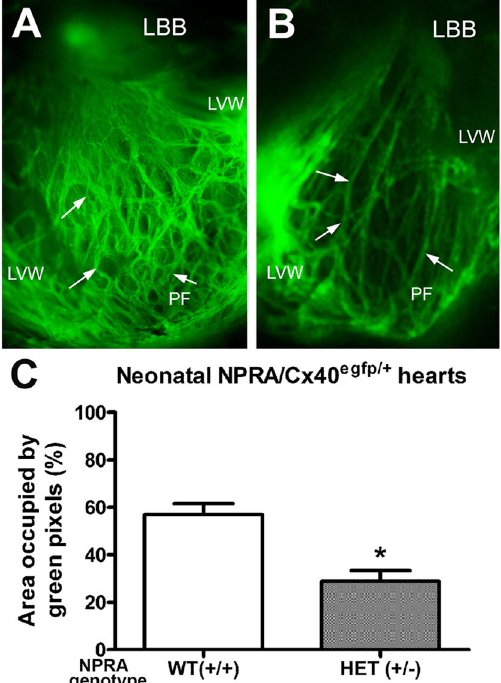
Figure 6. Quantification of ventricular conduction system development in neonate day 1 (ND1) ventricles of wild type (WT) and NPRA + / − mice using a Cx40 egfp + reporter approach. ( A ) In the left ventricles (LV) of Cx40 egfp/ + /NPRA + / + ND1 pups, the left bundle branch (LBB) was continuous with an extensively arborized Purkinje fiber (PF) network. Note the typical honeycomb pattern of PFs (arrows) in the septal surface and left and ventricular free wall (LVW). ( B ) In the LV of Cx40 egfp/ + /NPRA + / − pups, PF network appeared to be sparse with fewer egfp positive PF fibers (arrows) within the septal surface and LVW. N = 8–10 NDl pups per genotype. ( C ) Quantification of EGFP green pixels in ND1 ventricles of WT and NPRA + / − mice. * P < 0.005, Student’s unpaired